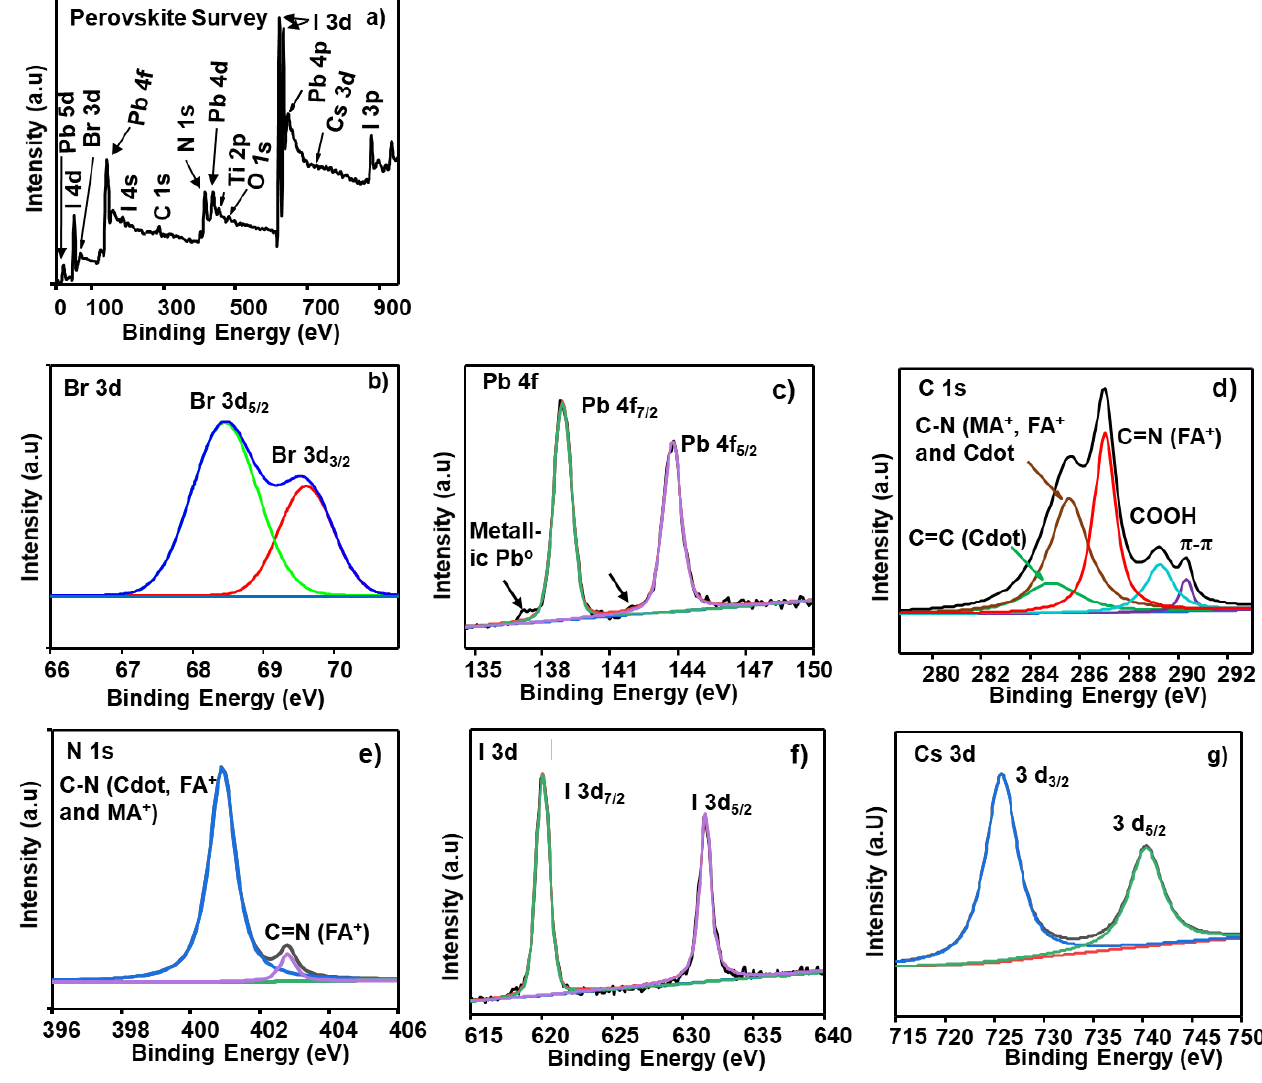
Figure 3. XPS spectra of ( a ) Survey; ( b ) Br 3d; ( c ) Pb 4f; ( d ) C 1s; ( e ) N 1s; ( f ) I 3d; and ( g ) Cs 3d of FTO/c-TiO 2 /meso-TiO 2 /Cdot/perovskite.